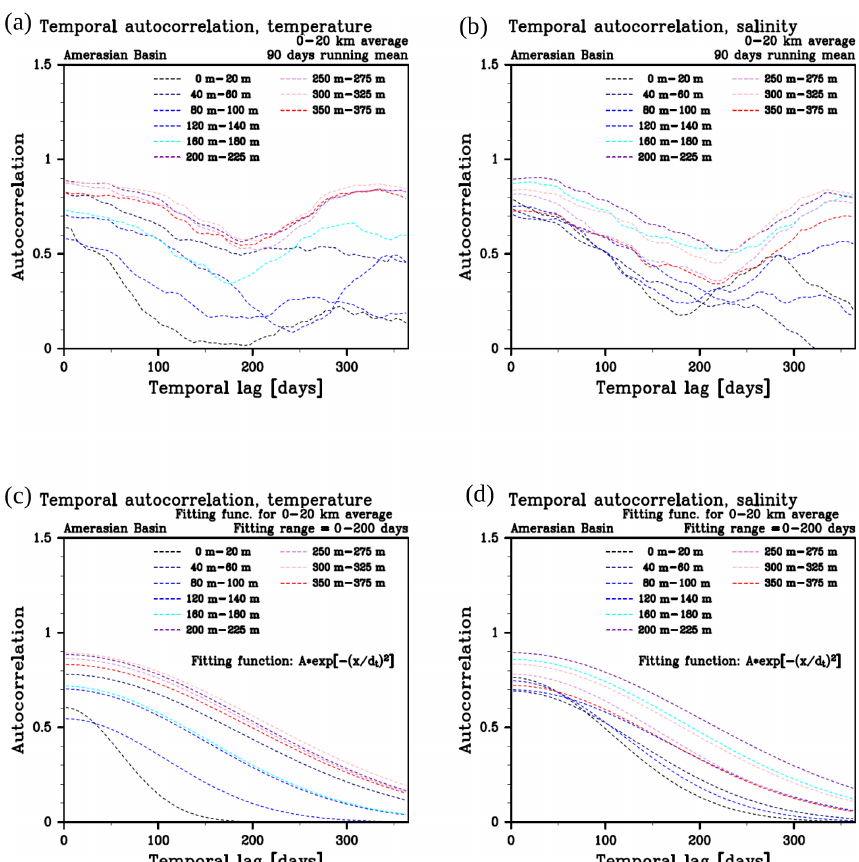
Figure 11. Temporal autocorrelation function of temperature (a, c) and salinity (b, d) . The upper panels show the spatial averages of the two- dimensional autocorrelation functions (the spatial average of 0–20km lag) in various depth levels. The lower panels are Gaussian functions, the intercepts and e -folding scales of which are calculated from the function fitting in a 0- to 200-day temporal-lag range. A 90-day temporal filter is applied to the autocorrelation functions in panels (a) and (b) to eliminate